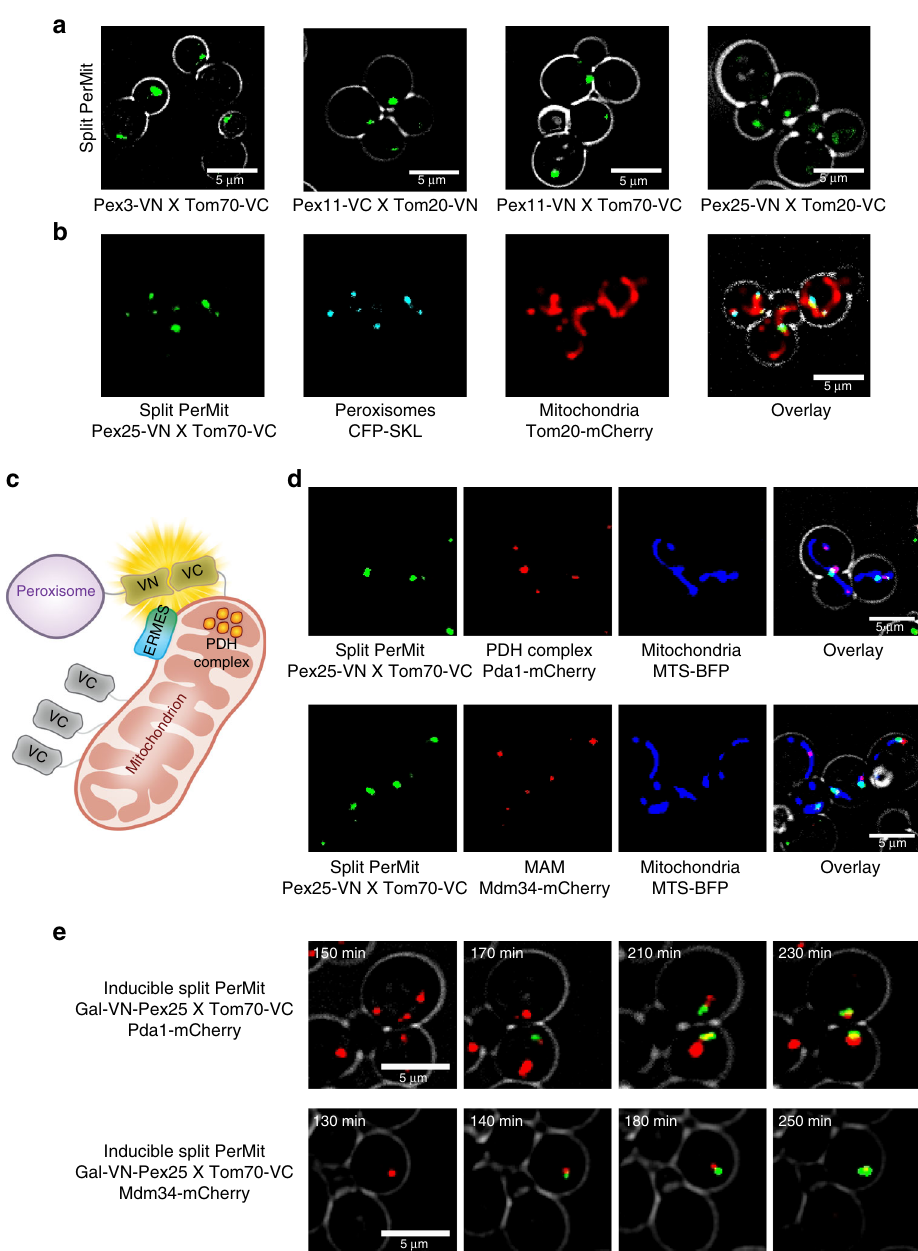
Fig. 2 The Peroxisome-Mitochondria (PerMit) reporter accurately reports on the contact site between the organelles. a Pairwise combinations of three different peroxisomal membrane proteins (Pex3/Pex11/Pex25) tagged with one half of the split Venus protein and one of two mitochondrial membrane proteins (Tom70/Tom20) tagged with the complementary split Venus half, all lead to a fl uorescent signal indicating that the two organelles are in close proximity and that the signal is not dependent on the marker protein used. b The PerMit reporter signal co-localizes to both a peroxisomal marker (CFP- SKL) and to a mitochondrial marker (Tom20-mCherry) demonstrating that it indeed marks sites of close apposition between the two membranes. c A schematic diagram showing that peroxisomes are found in proximity to speci fi c niches in mitochondria: the ER-Mitochondria contact site (represented by the ERMES tether complex) and to a mitochondrial niche in which the pyruvate dehydrogenase complex (PDH complex) is enriched. d The PerMit reporter indeed localizes in proximity to the mitochondrial (mitochondria are marked by MTS-BFP) niche that is enriched with PDH complexes (marked by Pda1- mCherry) and to ER-mitochondria contact sites (marked by Mdm34-mCherry) suggesting that it reports on real contact sites and not random sites of proximity. e Time point images (the time is indicated in white) of PDH complexes (marked by Pda1-mCherry) or ER-mitochondria contact sites (marked by Mdm34-mCherry) after shifting the cells to galactose (time:0) thus inducing the PerMit reporter by expressing its peroxisomal half (Gal-VN-Pex25). The images show that the PerMit reporter is formed next to existing Pda1 or Mdm34